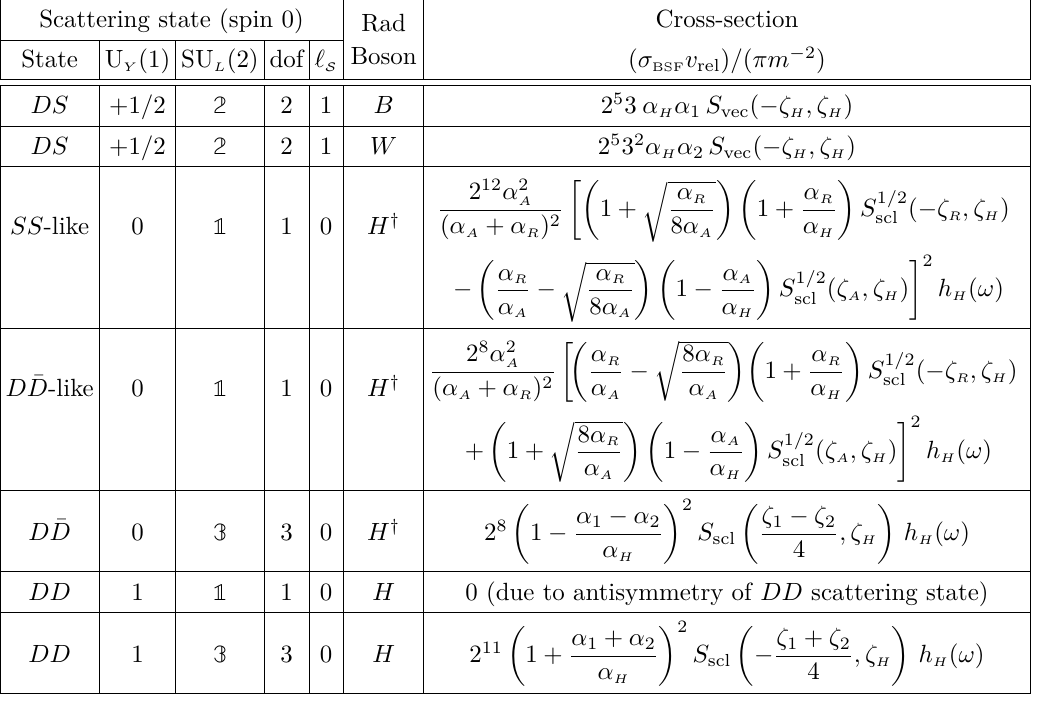
¯ and D -like states, α A + v 2 ) / 4 . All processes rel H